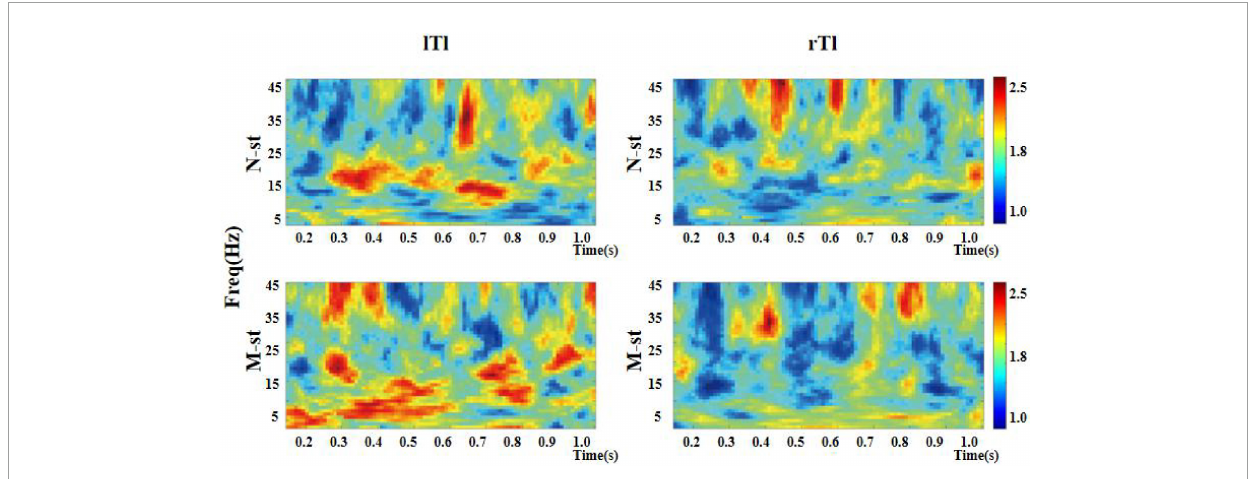
FIGURE8 Time-frequency distribution of ITPC in left and right auditory temporal lobes. "lTl" represents the left temporal lobe and "rTl" represents the right temporal lobe. "M-ST" represents the true meaning sound stimulation group, and the "N-ST" band represents nouns stimulation group. As can be seen in the figure, the ITPC value of the left temporal lobe is higher than that of the right temporal lobe.